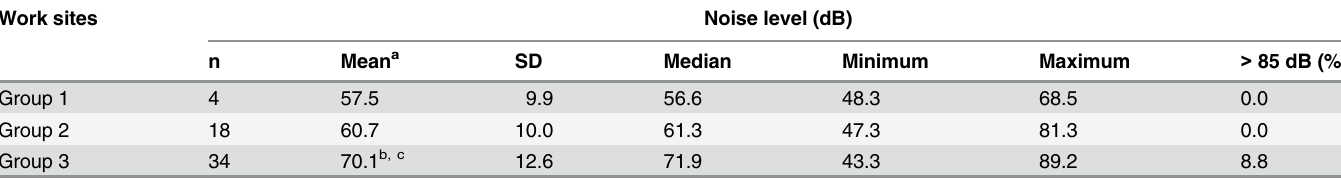
Table 2. Result of environmental noise monitoring by worksites of different groups of MSWL workers. Work